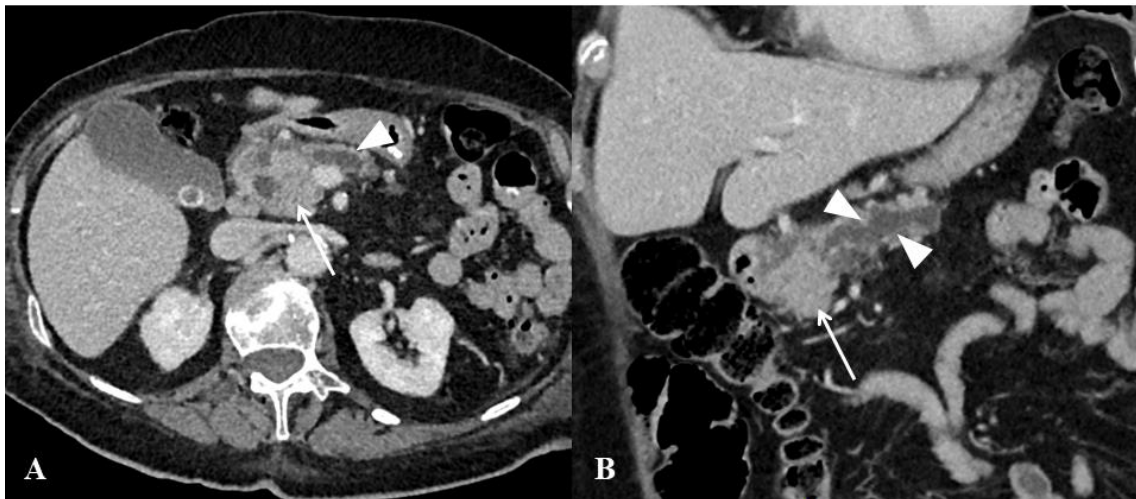
Figure 5. Computed tomography (CT) examination in a 72-year-old woman with pancreatic ductal adenocarcinoma. ( A , B ) CT images in the axial ( A ) and coronal ( B ) planes obtained during the portal venous phase show ill-defined mass of pancreatic head that results in upstream Wirsung duct dilatation (arrowheads).